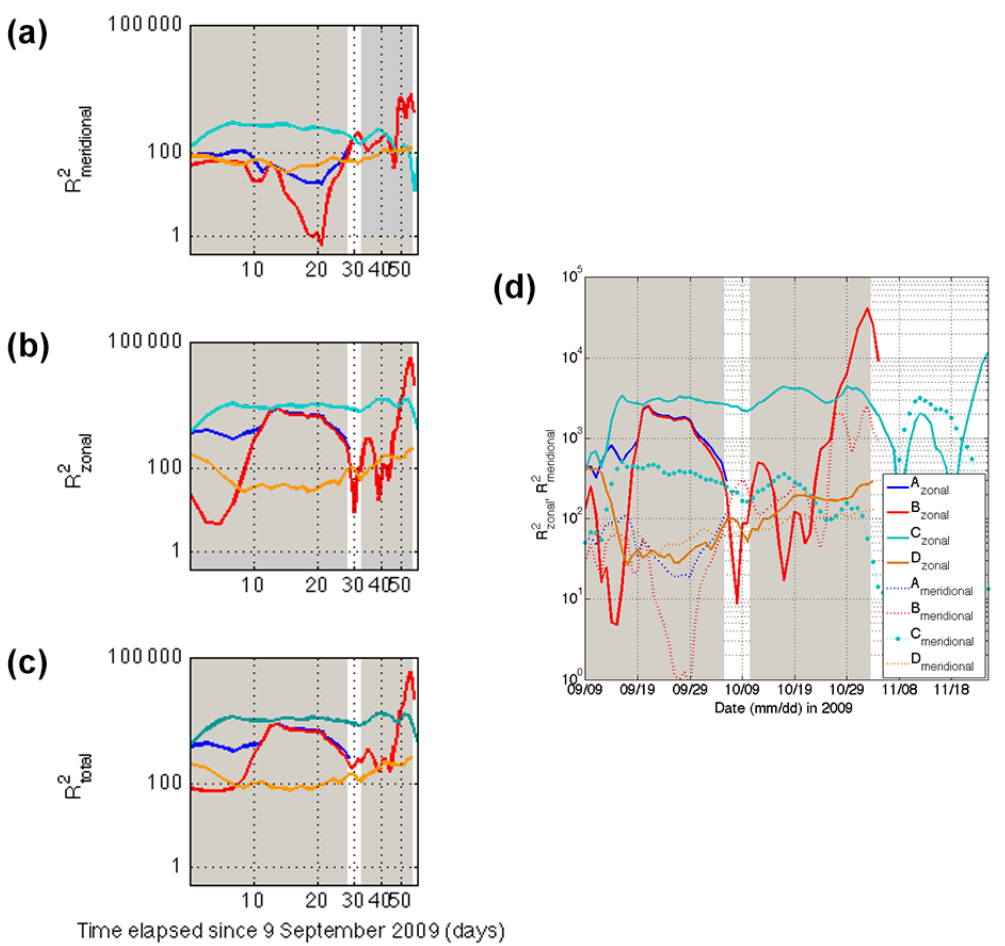
Figure 8. Relative (two-particle) dispersion showing (left column) meridional (a) , zonal (b) , and total (c) relative dispersion as a function of elapsed time since 9 September 2009 and (d) a superposition of zonal (solid line) and meridional (symbol dashed line) relative dispersion. Total dispersion is initially governed by zonal separation for triplets A, B, and C and by both zonal and meridional separation for triplet D. This distinction may be attributed to predominantly meridional motion (and along-shear transport) of triplet D along the eastern segment of the anticyclonic Beaufort Gyre. A significant decrease in zonal separation is observed near the ice edge in triplet B due to convergence in the ice cover in response to the 8 October SLP high. Inter-beacon distances also increase in the meridional direction and decrease in the zonal direction for triplet B following the SLP high on 8 October. A transition to a more isotropic state in the ice cover for triplets closest to the coastline is evident in comparable zonal and meridional separations in triplet B in particular (d) as beacons encounter lower ice concentrations (Fig.